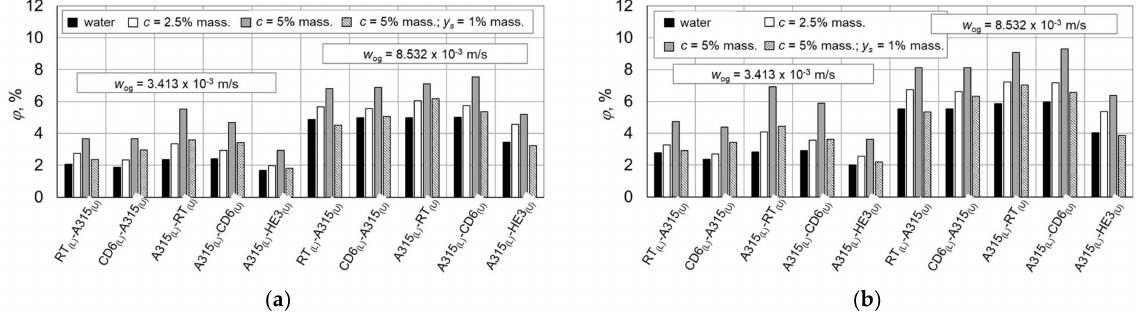
Figure 4. Dependence of ϕ = f(configurations of impeller); standard planer baffles, ( a ) n = 10 1/s; ( b ) n = 12